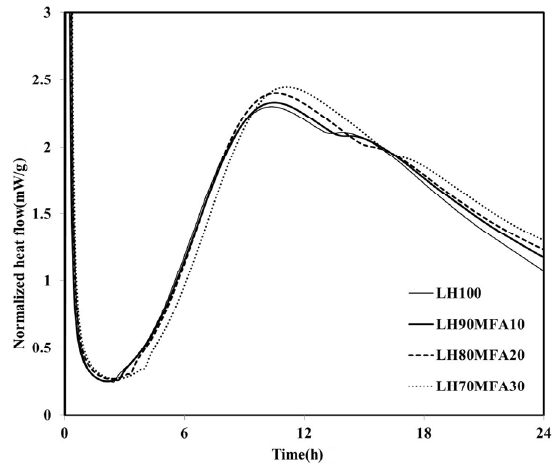
Figure 4. Normalized heat flows of LH90MFA10, LH80MFA20, and LH70MFA30.